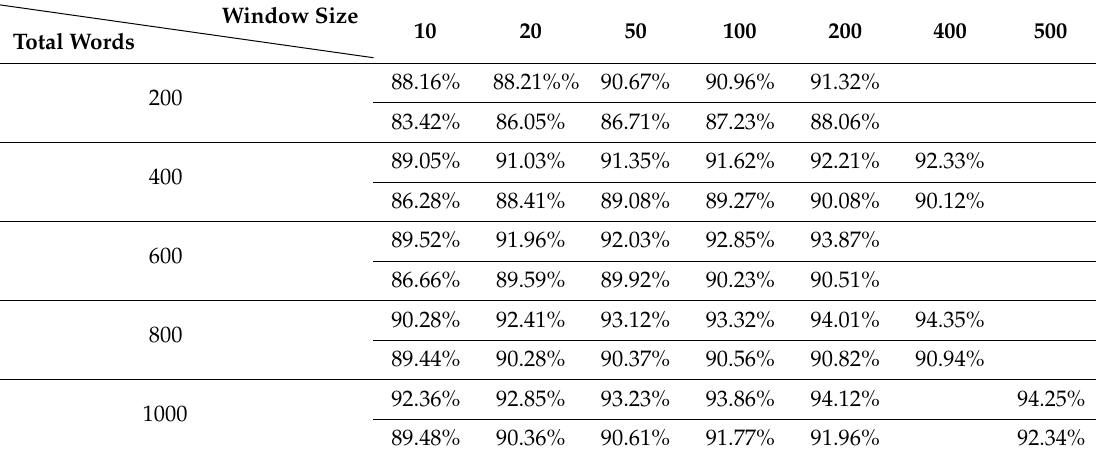
Table 3. Model CNN_LSTM_Agg experimental results.